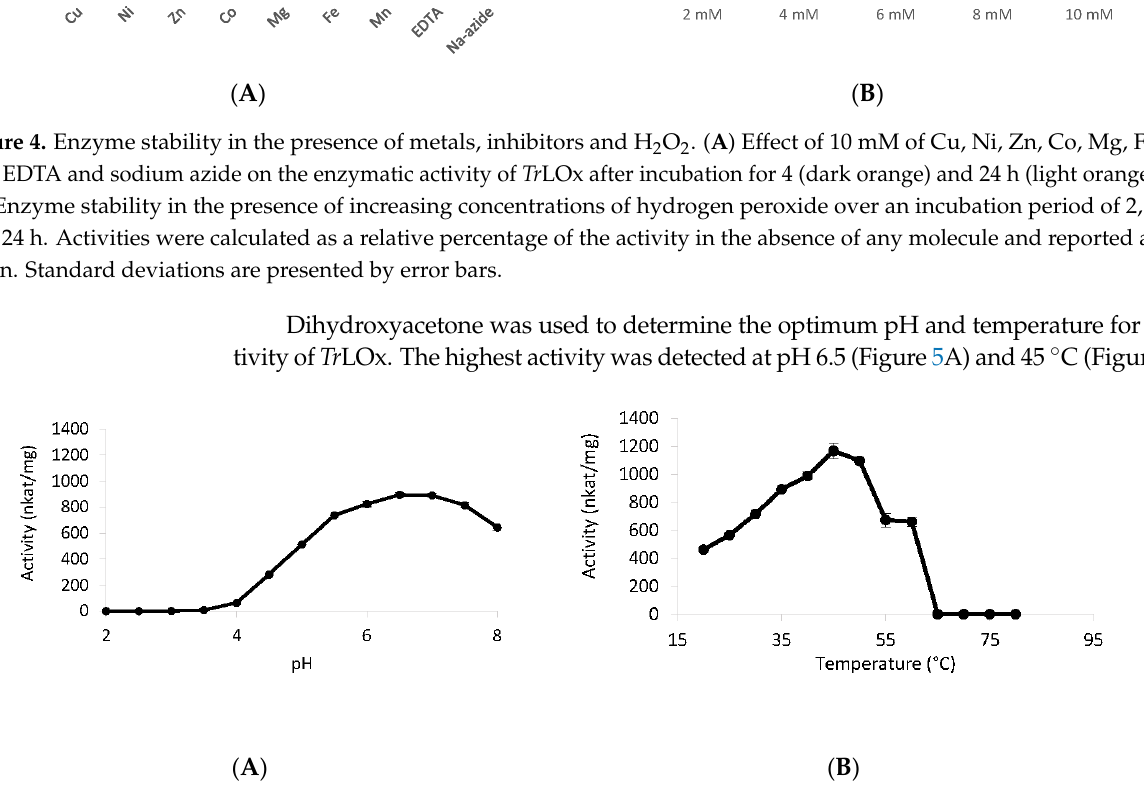
Figure 5. Optimum pH and temperature for the activity of Tr LOx. ( A ) Activity in Sodium tartrate (pH 2-6) and sodium phosphate (pH 6–8) buffers; ( B ) Measured enzymatic activity at different temperatures. Standard deviations are presented by error bars.